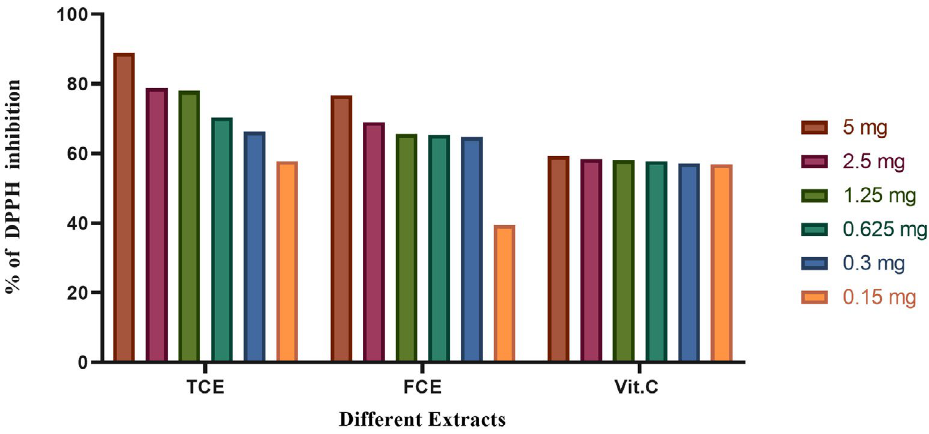
Fig. 7. The total antioxidants capacity using DPPH of vitamin C (Vit C), the total culture extract (TCE), and the free cell extract (FCE) .